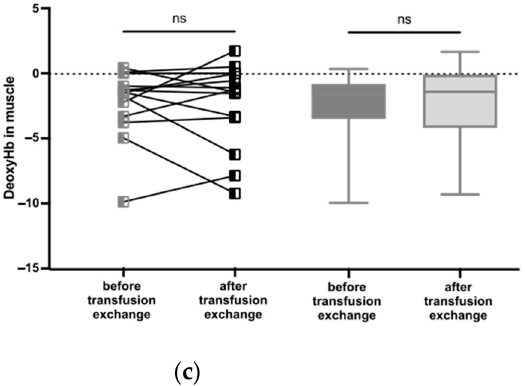
Figure A2. Measurement of the relative amounts of DeoxyHb before and after BET. Box whisker plots show range, interquartile percentages, and median values for DeoxyHb. ( a ) DeoxyHb in cerebral hemispheres with steno-occlusive arterial disease ( n = 13). ns using the Wilcoxon test. ( b ) DeoxyHb in cerebral hemispheres without steno-occlusive arterial disease ( n = 19). ns using the Wilcoxon test. ( c ) DeoxyHb in muscle ( n = 14). ns using the Wilcoxon test.